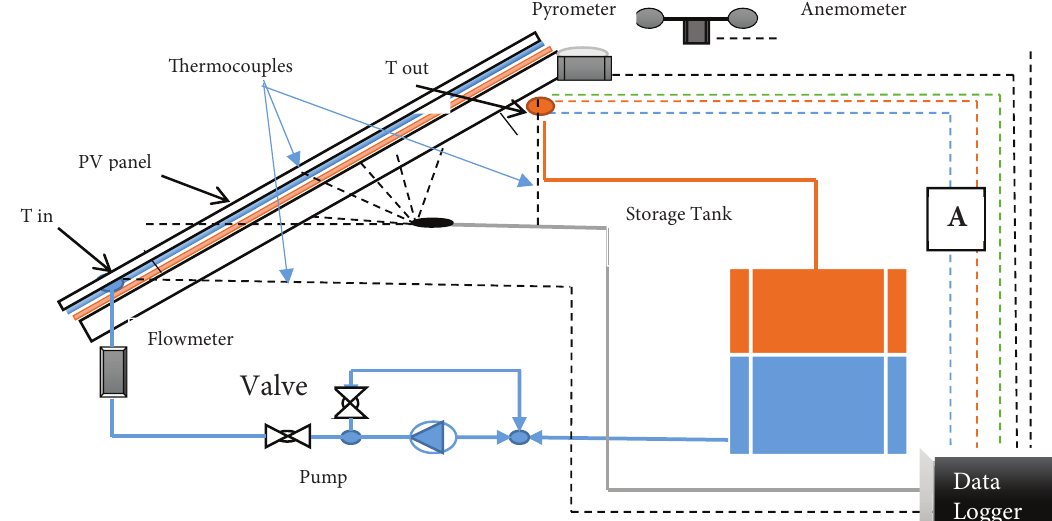
Figure 3. Schematic diagram of the